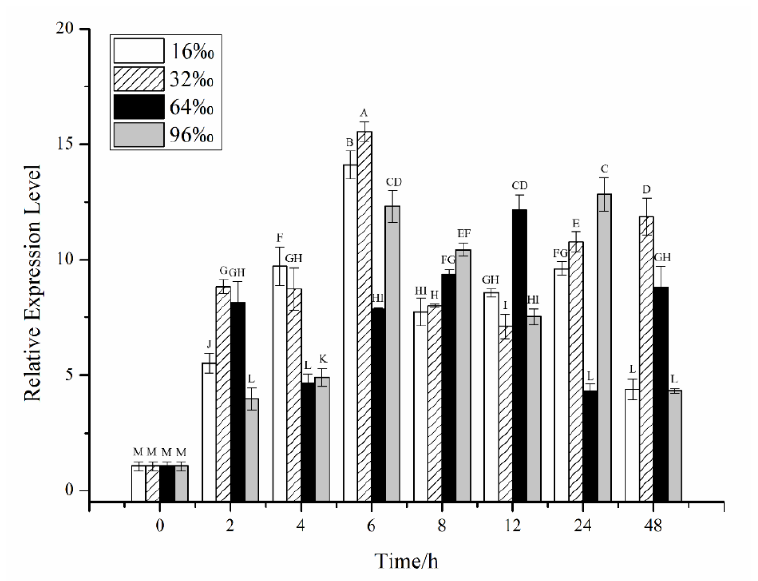
Figure 4. Relative expression of the CiPlant-CRY1 in salinity of 16‰, 32‰, 64‰, and 96‰ for different times. Standard error bars are shown, n = 3. Different capital letters indicate significant differences between different treatments ( p < 0.01).